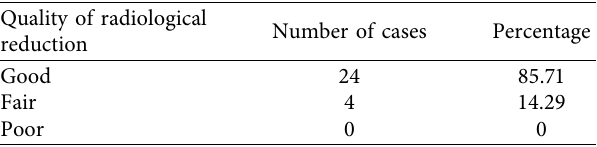
Table 4: Control of the radiological quality of reduction according to the Arlettaz criteria